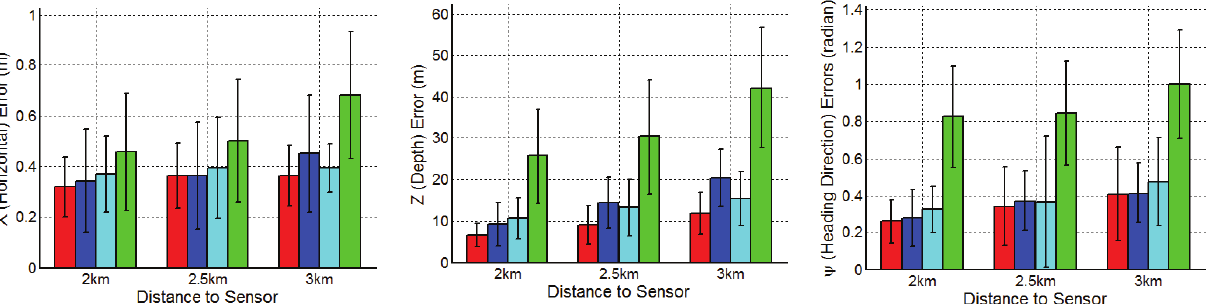
Figure 10. Comparison of the tracking errors of the horizontal position, slant range and heading direction. In each plot, the results for each method averaged over eight target types for each range. From left to right, the plot gives the results for JVIM (first, red), couplet of view and identity manifolds (CVIM) (second, blue), local linear (LL)-Gaussian process latent variable model (GPLVM) (third, cyan) and nearest neighbor (NN) (forth, green). (Reprint from [24], with permission from